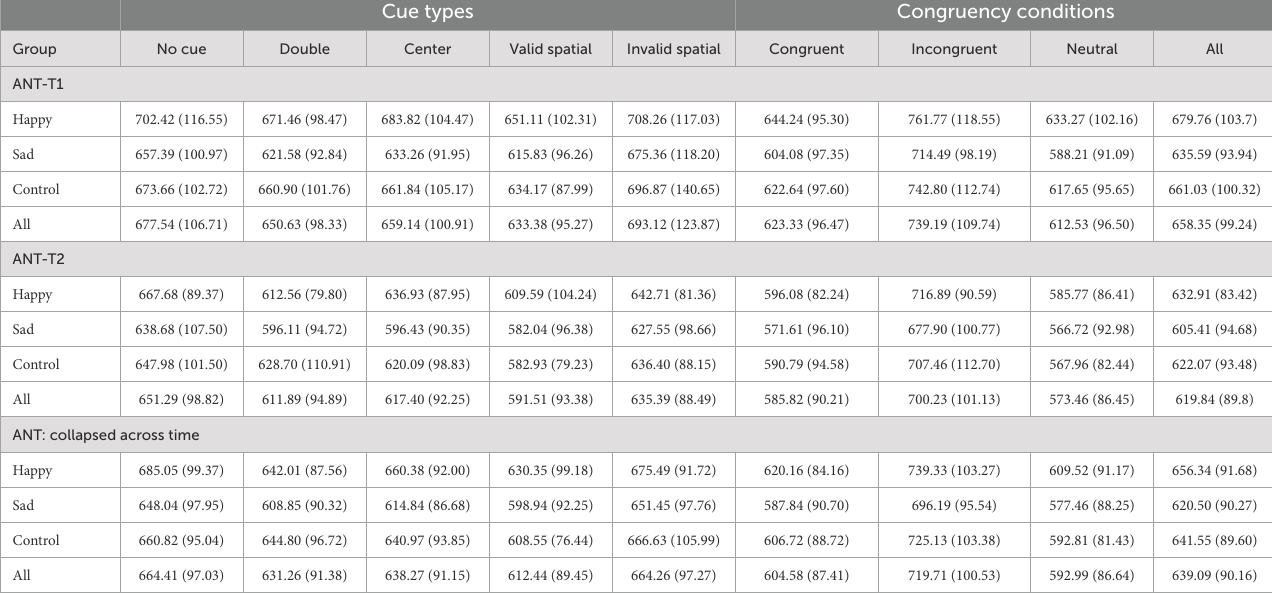
TABLE 2 The means and standard deviations (in parentheses) for the ANT separated by group and time. Cue